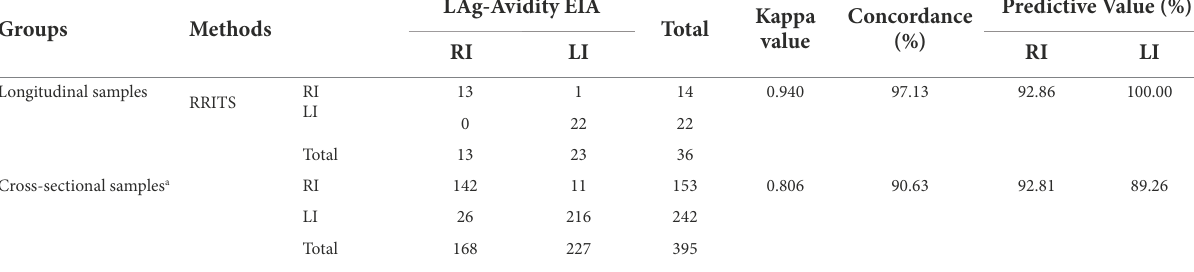
TABLE 1 Comparison of rapid recent-infection testing strip (RRITS) and LAg-Avidity EIA to distinguish HIV-1 recent and long-term infection.